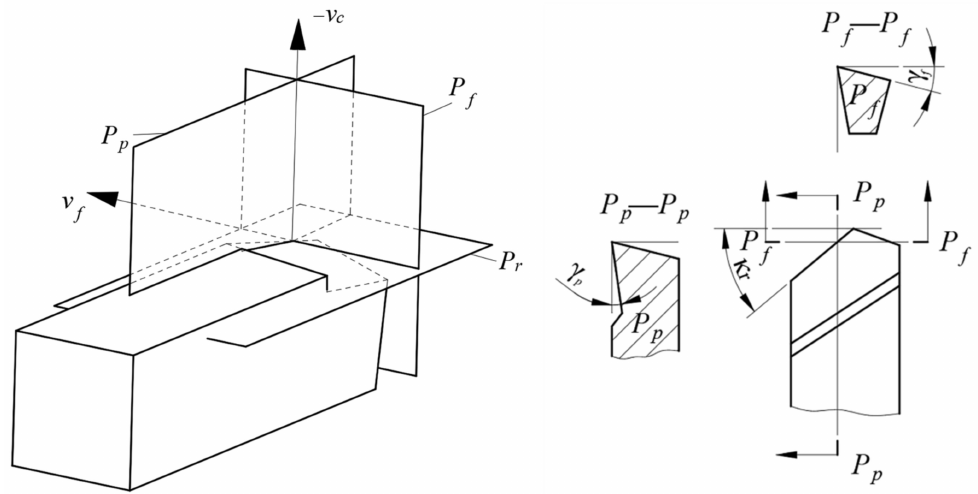
Figure 11. The assumed working plane coordinate system and the tool parameters